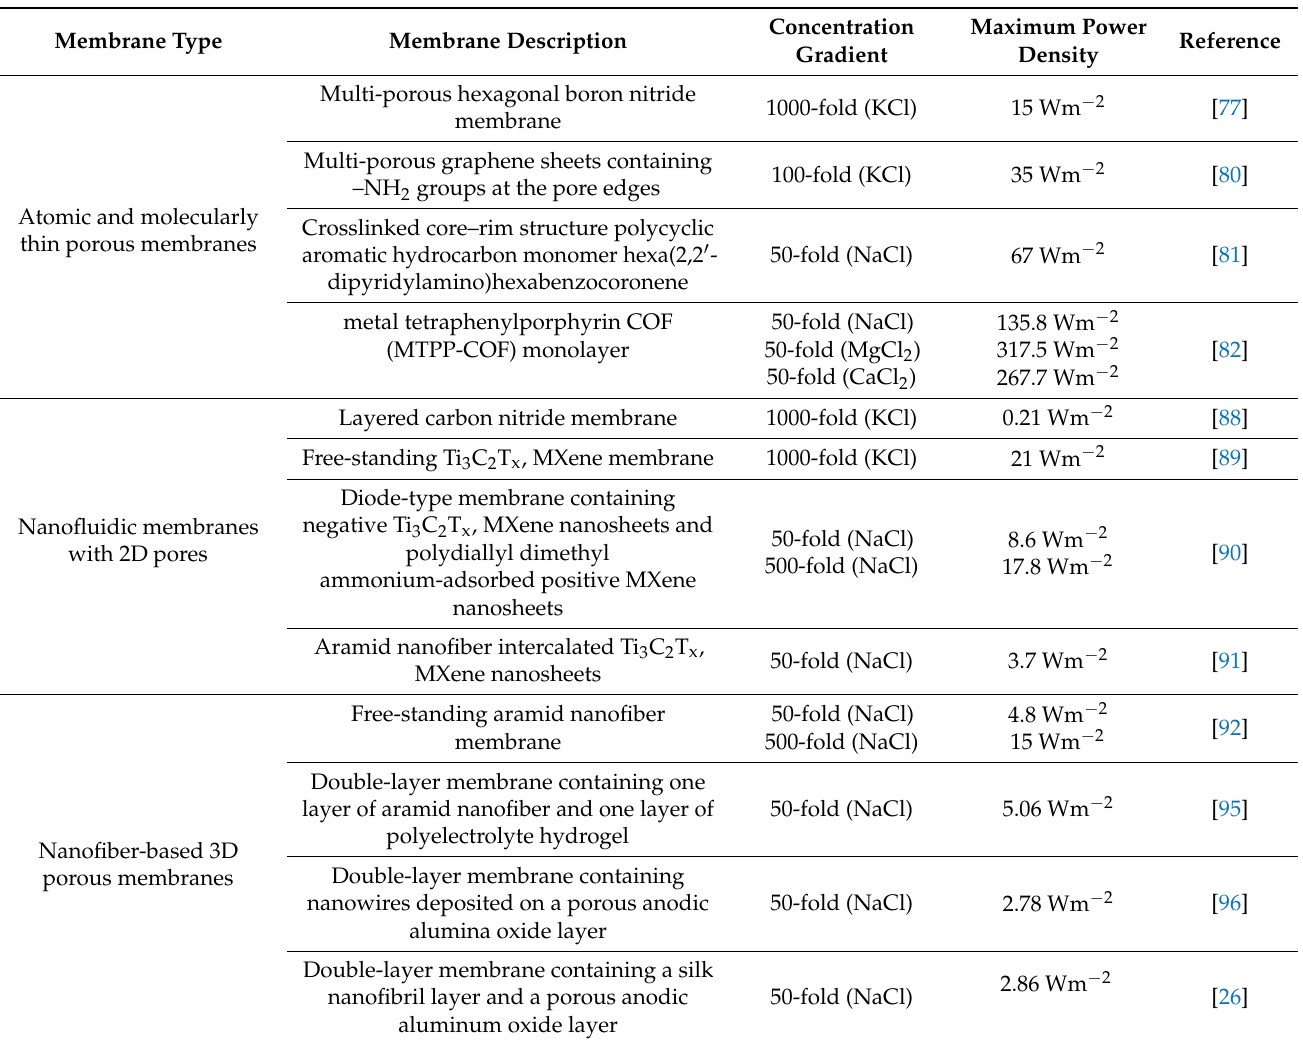
Table 1. Comparison of the maximum power densities obtained from different types of multi- porous